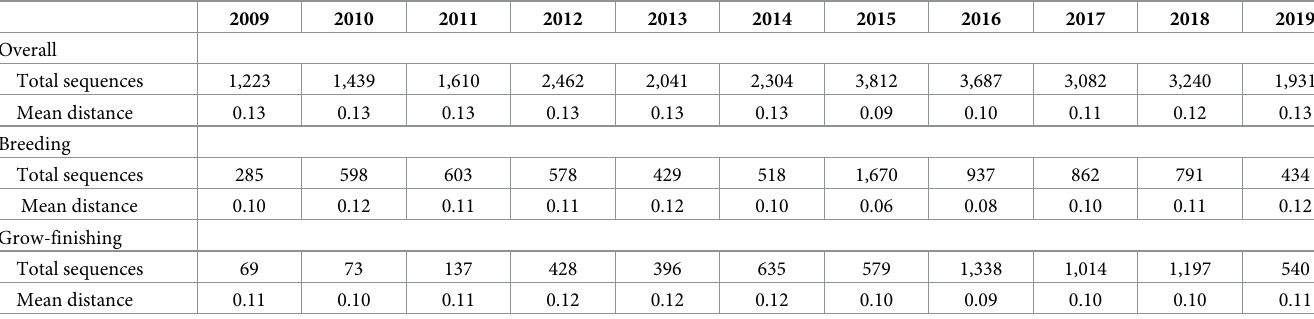
Table 1. Within-year mean ORF5 genetic distance as proportion nucleotide differences overall and by herd